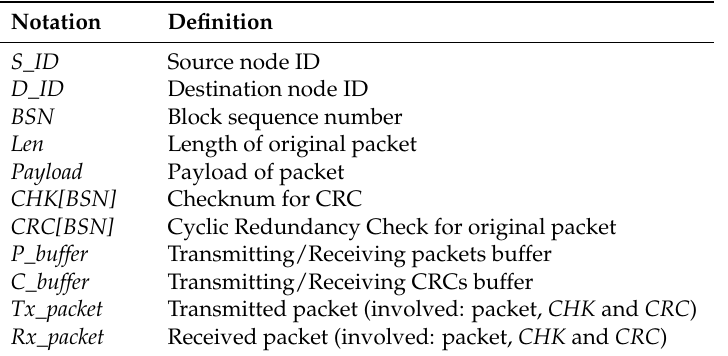
Table 1. Summary of notations.